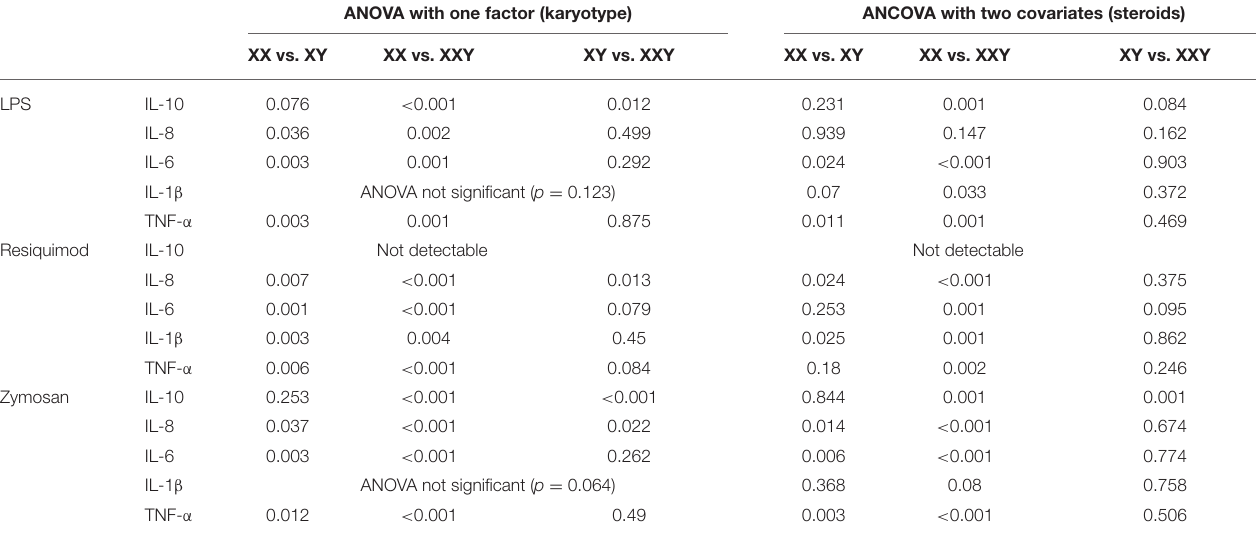
TABLE 3 | Comparison of p -values obtained with one-way ANOVA with one group factor (karyotype) at three levels (XX, XXY, XY), and p -values obtained with one–way ANCOVA with estradiol and testosterone as covariates, performed on the levels of cytokines secreted by purified monocytes after stimulation with LPS, resiquimod, and